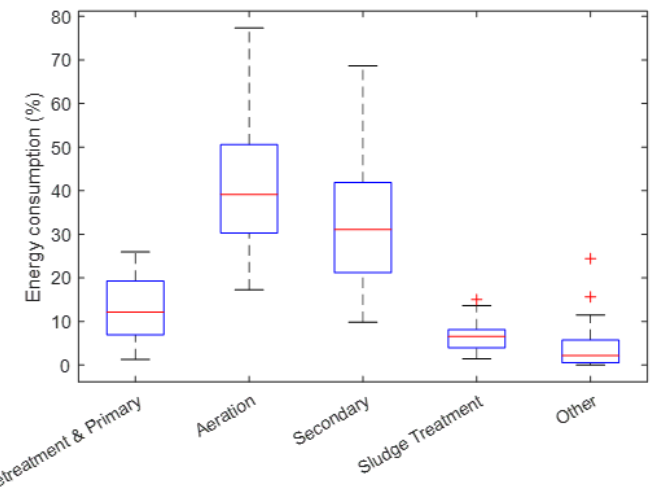
Figure 6. Average Proportional Energy Consumption by WWTP treatment phase.